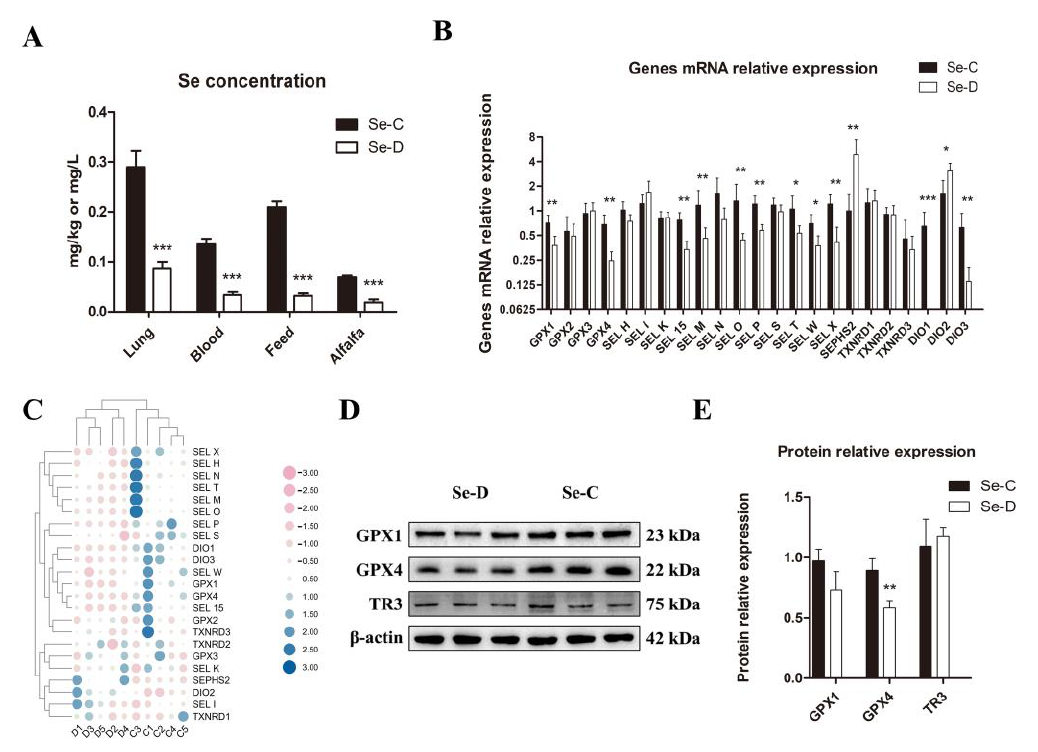
Figure 1. Se contents in lungs, blood, and foods ( A ), selenoprotein expression at gene ( B , C ) and protein ( D , E ) levels between Se-deficient and healthy calves. The mean ± SD is used to present the data above, n = 5 calves per group (except for WB n = 3). * p < 0.05, ** p < 0.01, *** p < 0.001.